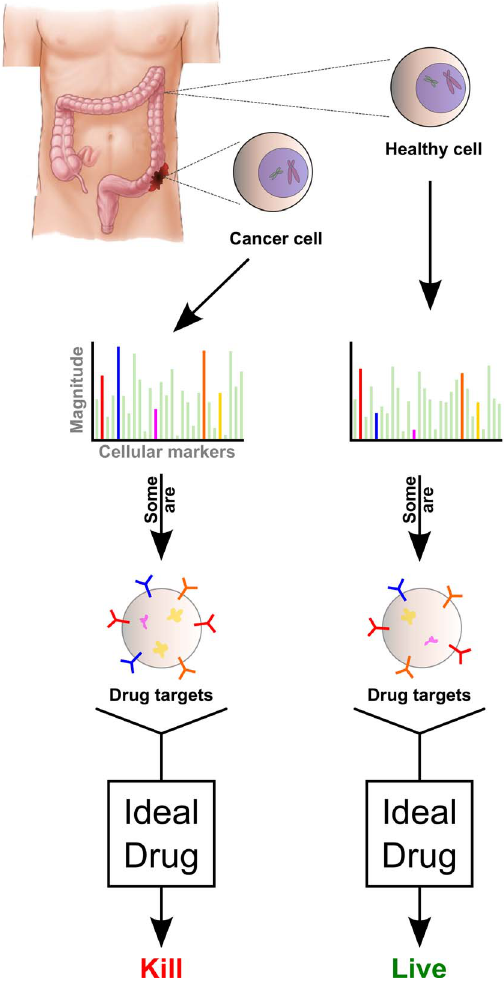
Figure 1. Cancer drugs solve a discrimination problem. Ideally, cancer drugs perform a computation on cells: kill (if cancerous) or no-kill (if healthy).